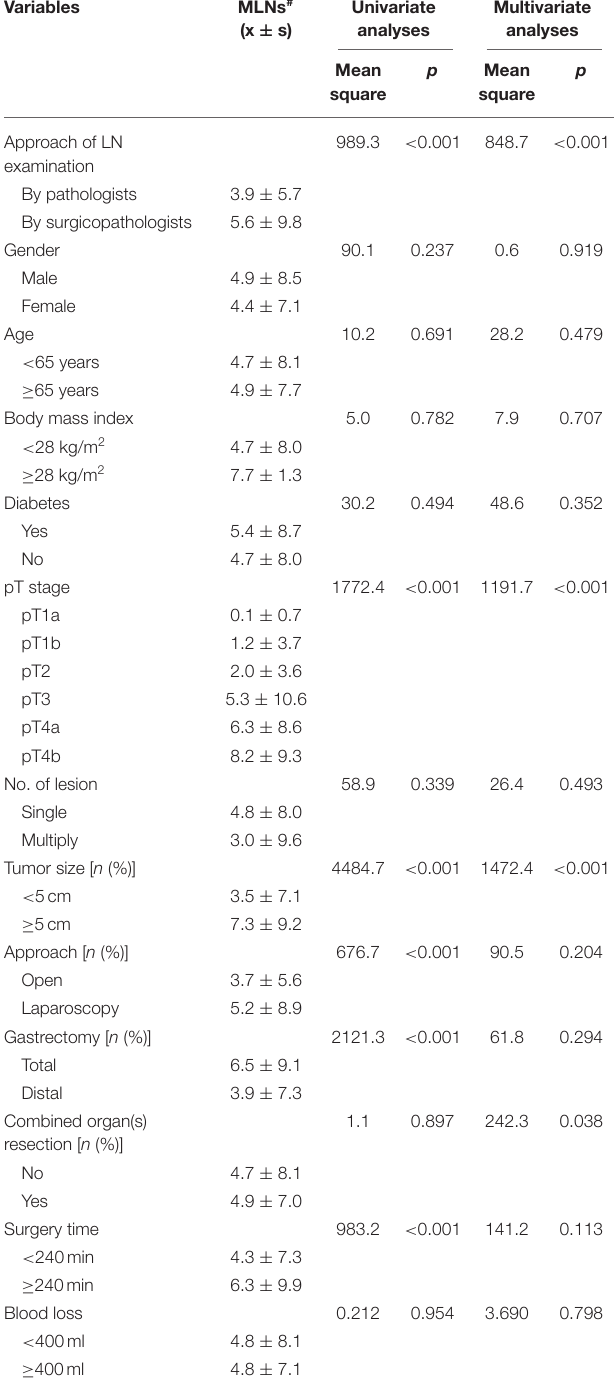
TABLE 4 | Univariate and multivariate analyses of factors influencing the detecting of metastatic lymph node in this cohort.